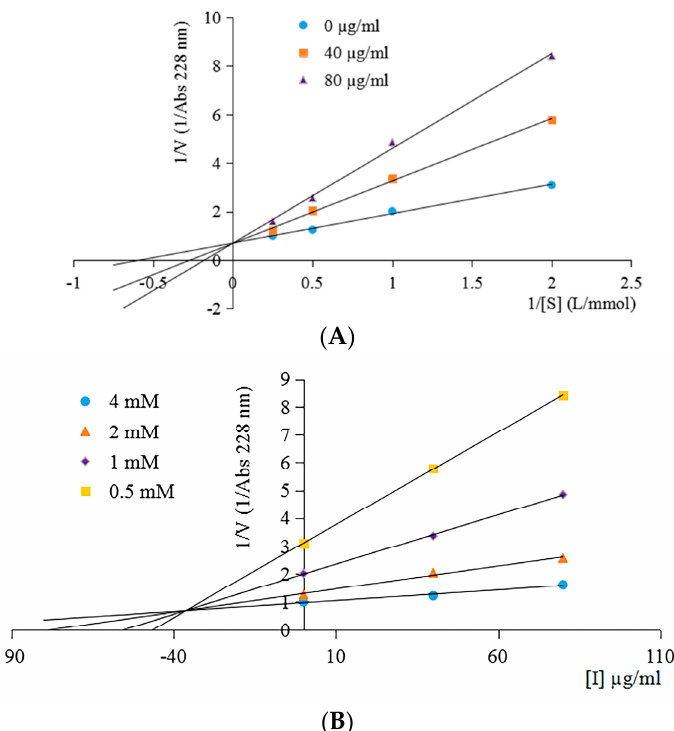
Figure 5. Lineweaver–Burk plot of ACE inhibition of the purified peptide (KSHPH − F 9-III ) at concentra- tions of 40 and 80 µg/mL ( A ); the Dixon plot was used to calculate the inhibition constant Ki of the peptide ( B ).